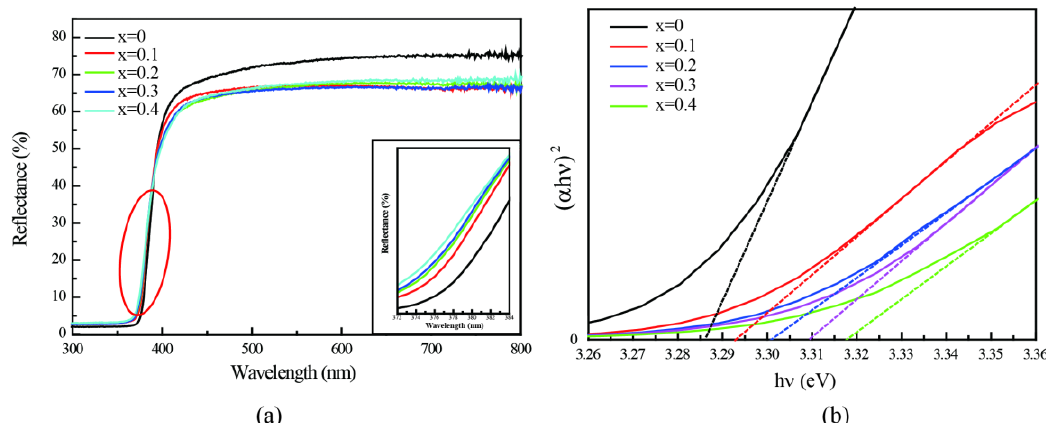
Figure 5. ( a ) UV reflectance spectra of Zn 1− x Mg x O nanoparticles; the inset is the enlarged figure in the red circle; ( b ) Tauc plots for determination of optical band gap energy of Zn 1− x Mg x O nanoparticles.